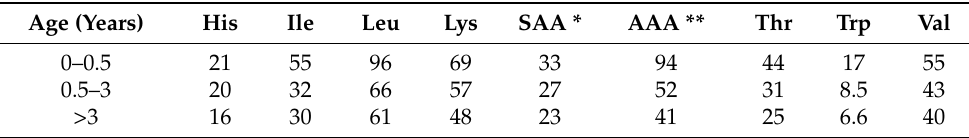
Figure 2. Elements required to quantitively define protein quality. Table 2. Recommended reference pattern for indispensable amino acids (in mg/g protein) for humans in different age groups (data from